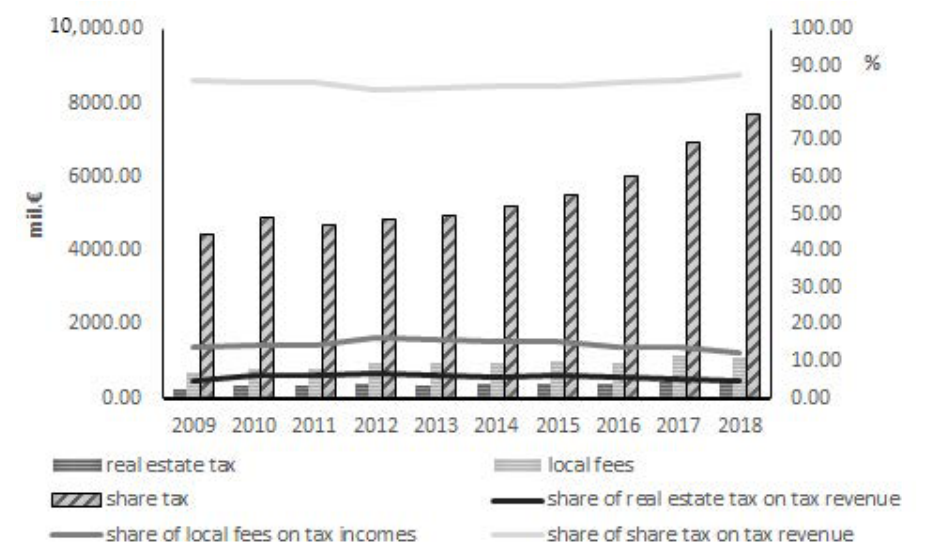
Figure 6. The share of individual categories of tax revenues of the municipalities in Czech Republic in the time period 2009–2018, Source: Czech Statistical O ffi ce, own